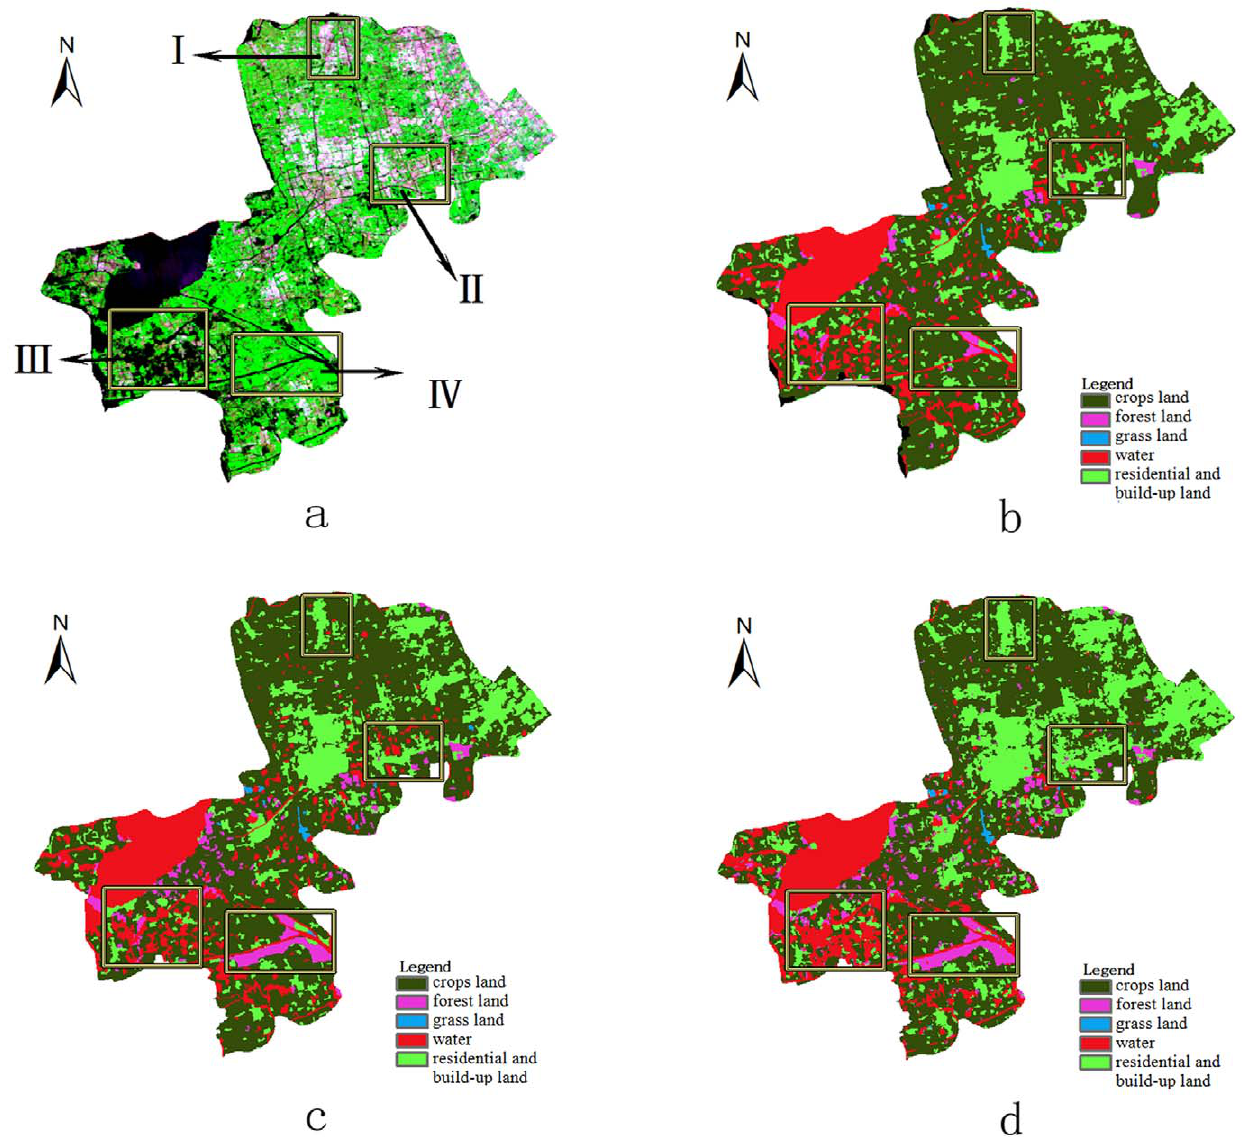
Figure 5. Comparison of land cover classification of Qingpu District. (a) HJ-1 image of 2009.9.22;(b) land cover of 2005;(c) land cover of 2009;(d) land cover classified by the proposed